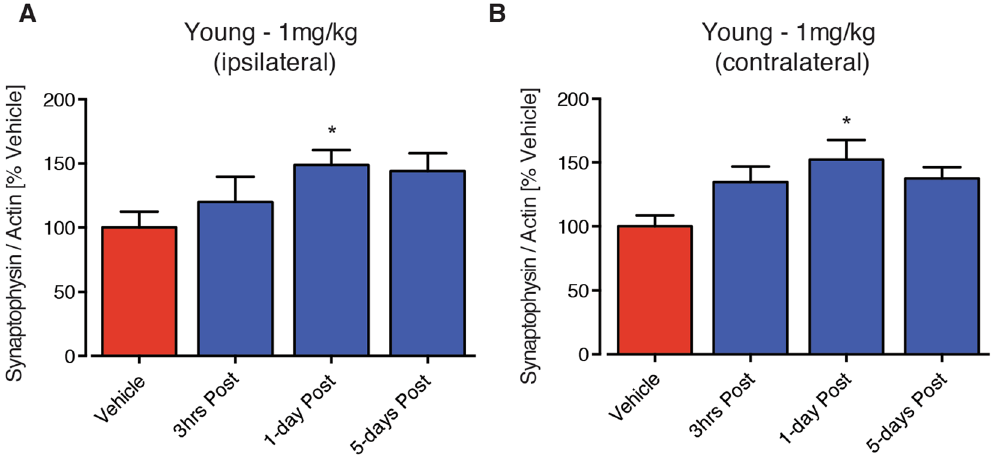
Figure 6. PEG-IGF-I increases the expression of the presynaptic protein, synaptophysin 7-days post-stroke both ipsilateral (stroke side: A ) and contralateral (non-stroked side: B ) to the lesion. An n = 5 per group were used for these studies. * P < 0.05, compared to aged-matched stroke + vehicle-treated